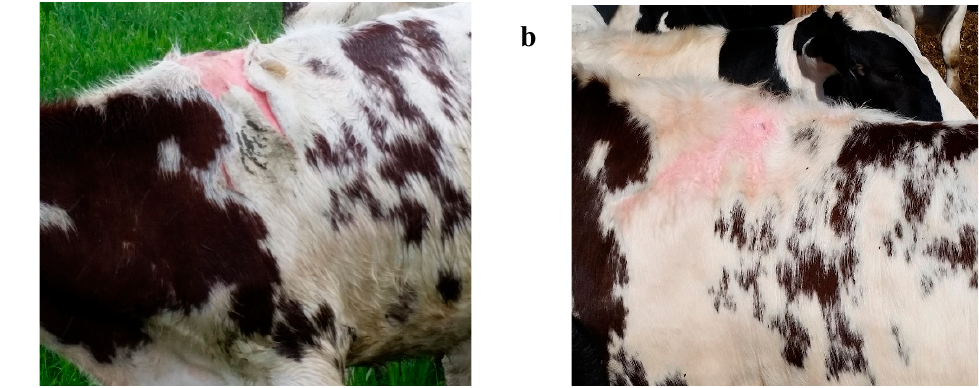
Figure 2. ( a ) Steer with clinical signs of photosensitivity on unpigmented skin. ( b ) Recovered steer from Figure 2a. Hair did not regrow on areas where skin was sloughed.